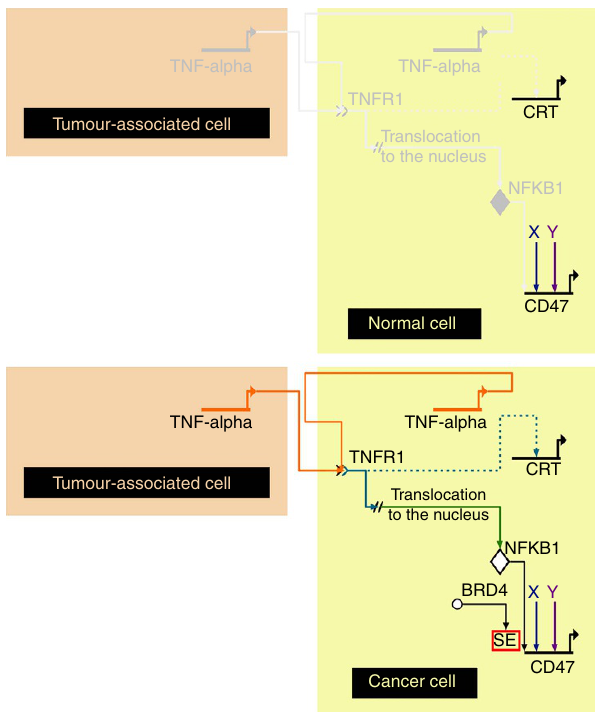
Figure 7 | Schematic model representing how CD47 transcriptional expression is regulated during inflammation in cancer. The TNF pathway activates the translocation to the nucleus of NFKB1. Upstream unknown factors, bind to closed DNA, making SE constituents accessible to NFKB1 binding, which in turn activate SEs and recruit BRD4 to these SEs promoting the interaction between the distal SE(s) and the promoter of the gene to initiate transcription. Dotted lines indicate indirect interactions while solid lines indicate direct